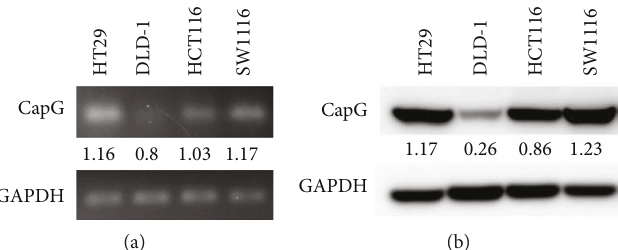
Figure 2: The mRNA and protein expression levels of CapG in four human colorectal carcinoma cell lines. Four human CRC cell lines including HT29, DLD-1, HCT116, and SW1116 were used to analyze the expressions of (a) mRNA and (b) protein of CapG. GAPDH was used as a loading control.